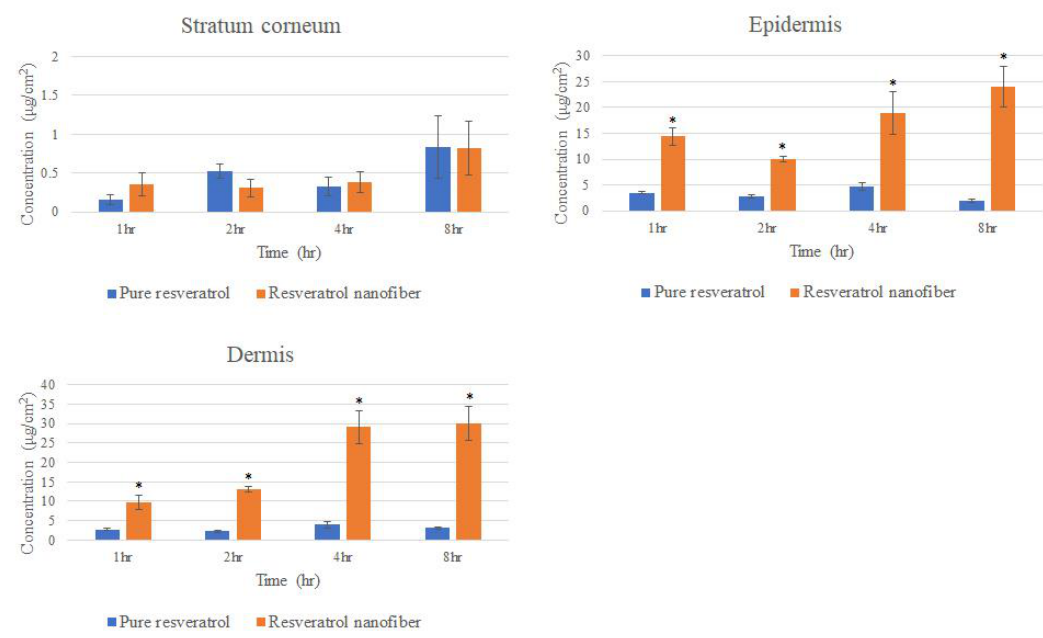
Figure 8. E ff ects of pure resveratrol and resveratrol nanofibers on skin penetration through pig skin. The amount of drug in the stratum corneum, epidermis and dermis at various time points were determined. Results are shown as mean ± SEM ( n = 6). * represents P < 0.05 when compared to pure resveratrol.